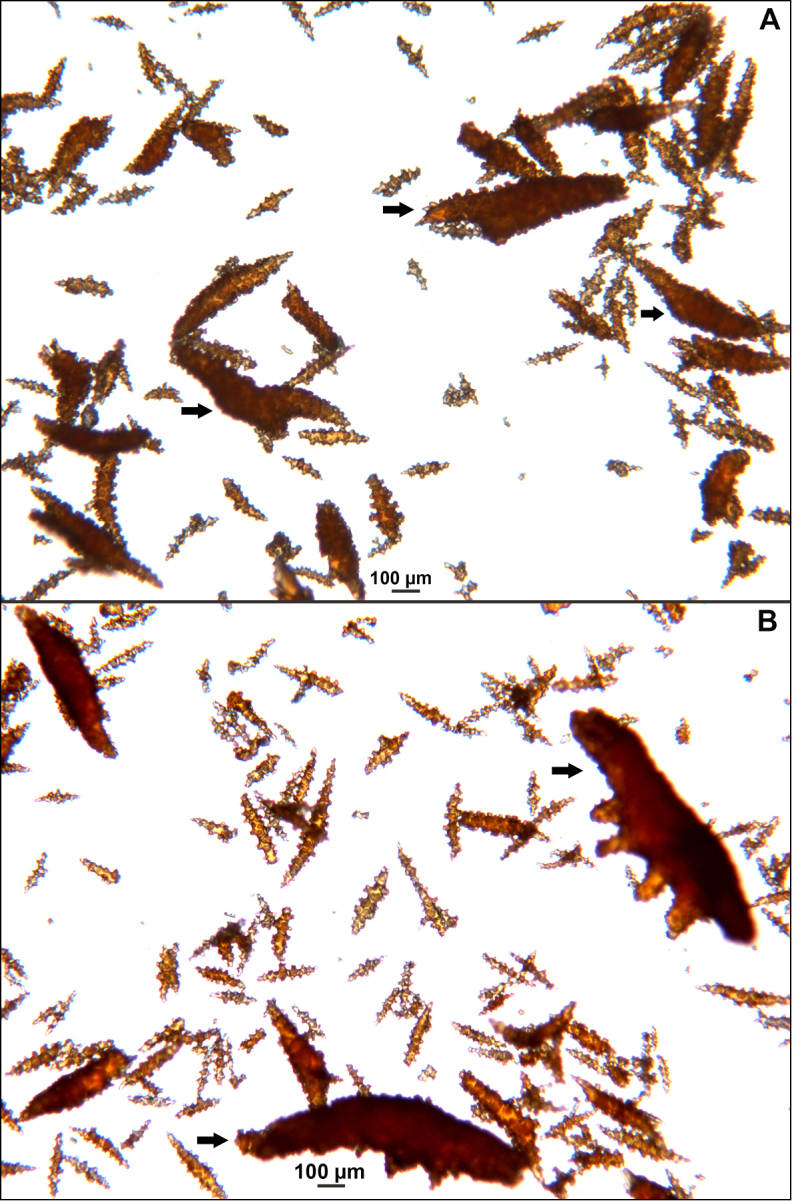
Muriceafruticosa, SBMNH 265940, light microscopy arrays. A, B 4× magnification, with diverse sclerites shown for the species. Of particular interest are prominent sclerites, indicated by arrows, in B (the tardigrade-like form mentioned in text description). In B the lower, middle sclerite measures some 1300 µm in length, the one up and to the right of that measures 1133 µm; thinner spindles measure between 200–300 µm in length.